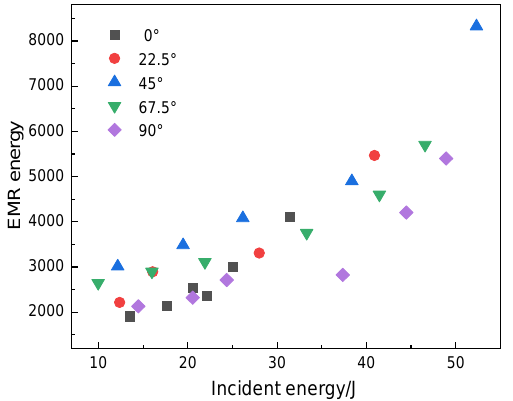
Figure 15. The relationship curve between EMR energy and incident energy.